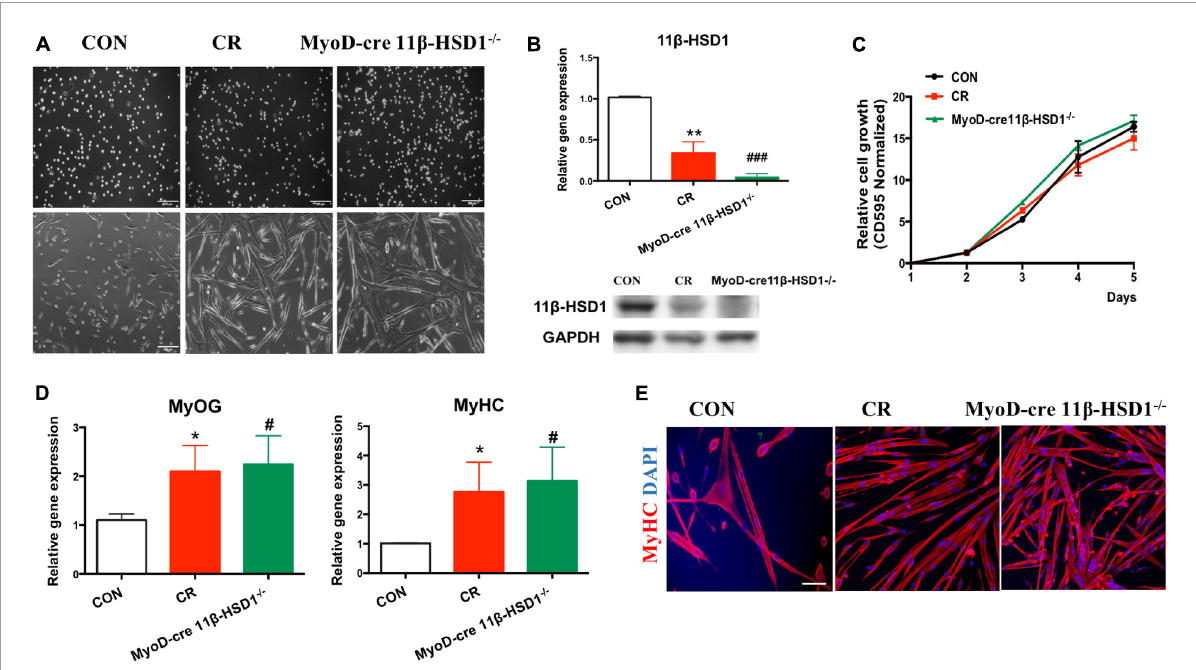
FIGURE5 The differentiation ability of mouse muscle stem cells (MuSCs) in MyoD-cre 11 β -HSD1 KO and CR mice was improved. (A) MuSCs were isolated from CR and MyoD-cre 11 β -HSD1 − / − and control mice at 22 months of age. Muscle-specific 11 β -HSD1 knockout mice and CR mice displayed better differentiation ability, as indicated by their larger myofibers. Scale bars, 200 µ m. (B) Gene and protein expression levels of 11 β -HSD1 in MuSCs of CR and MyoD-cre 11 β -HSD1 − / − and control mice. (C) The proliferation rates of MuSCs sorted from 22-month-old CR and 11 β -HSD1 − / − mice and their wild-type counterparts were detected by MTT assay. (D) Gene expression levels of MyHC and MyOG in 11 β -HSD1 − / − mice and CR mice during the differentiation of MuSCs. * p < 0.05, ** p < 0.01; # p < 0.01, ### p < 0.001. *CR mice compared with CON; #MyoD-cre 11 β -HSD1 − / − mice compared with CON. (E) Representative immunofluorescent staining images of cultured MuSCs at 3 days of differentiation from CR and MyoD-cre 11 β -HSD1 − / − and control mice at 22 months of age. Red indicates MyHC staining; DAPI indicates nuclei. Scale bars, 200 µ